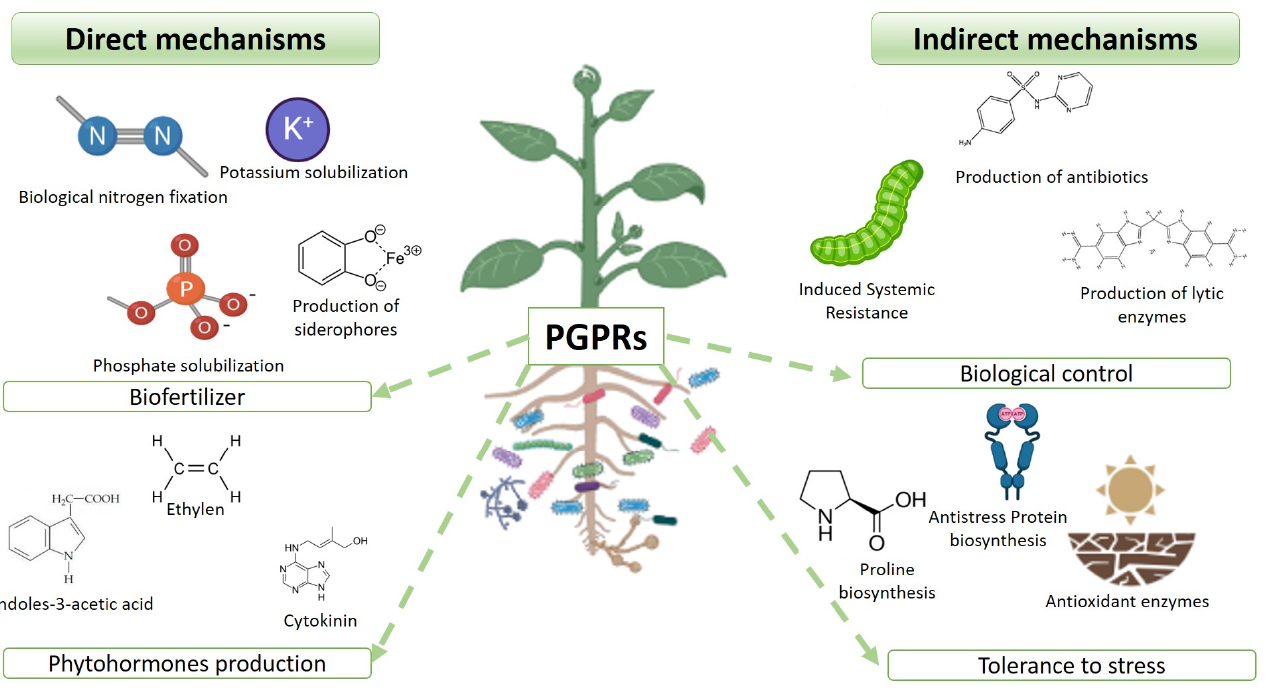
Figure 1. Direct and indirect mechanisms of PGPRs.